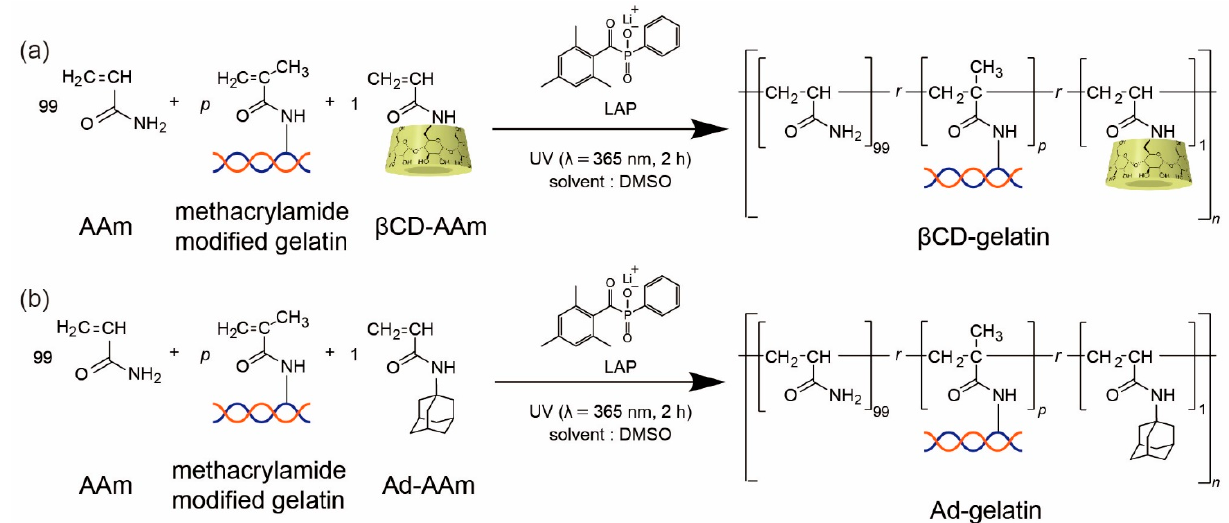
Scheme 3. Synthesis of ( a ) β CDgelatin and ( b ) Ad-gelatin for post-conjugation (Method